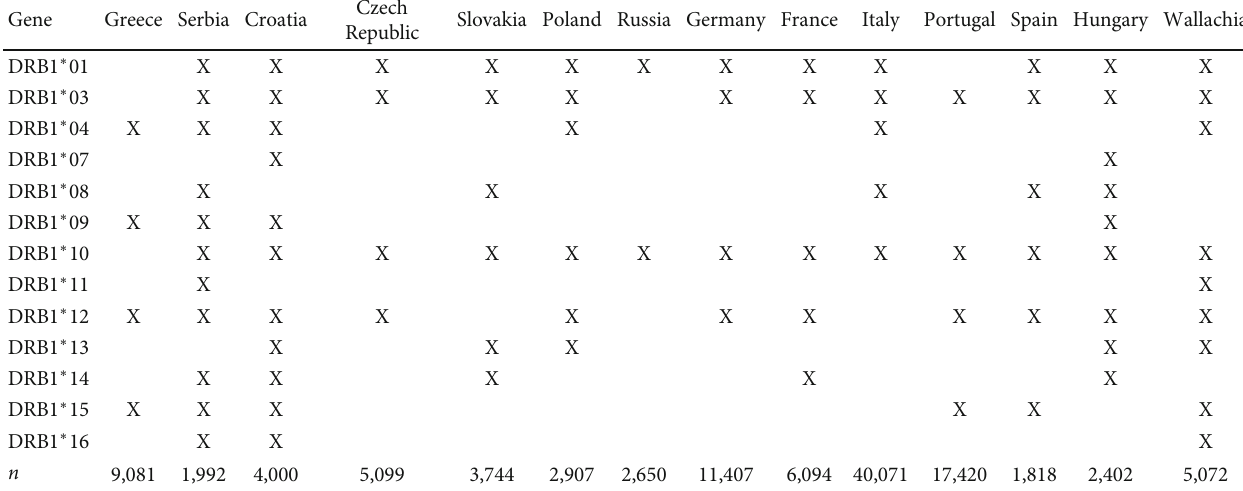
Table 7: Comparison of HLA-DRB1 gene frequencies in the Transylvanian ( n = 2,719 ) vs. other European population groups.